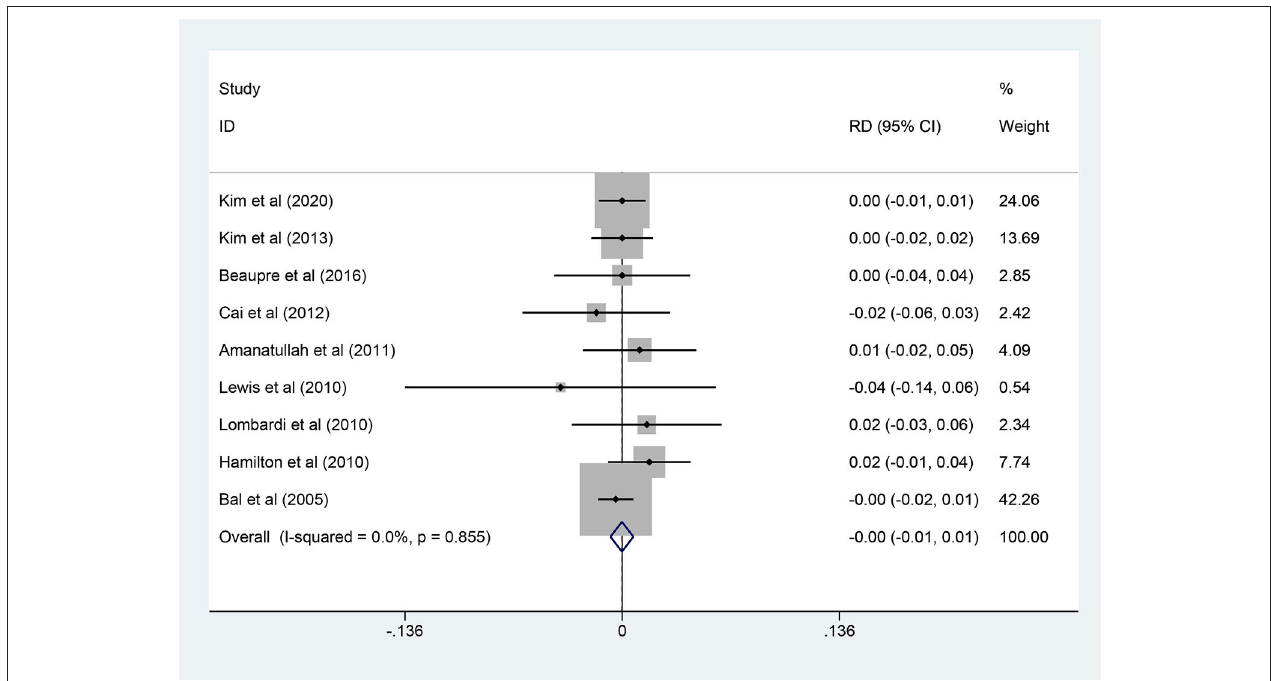
FIGURE 8 | Forest plot diagram of the prosthesis loosening rate of the replaced hip with COC and COP bearing